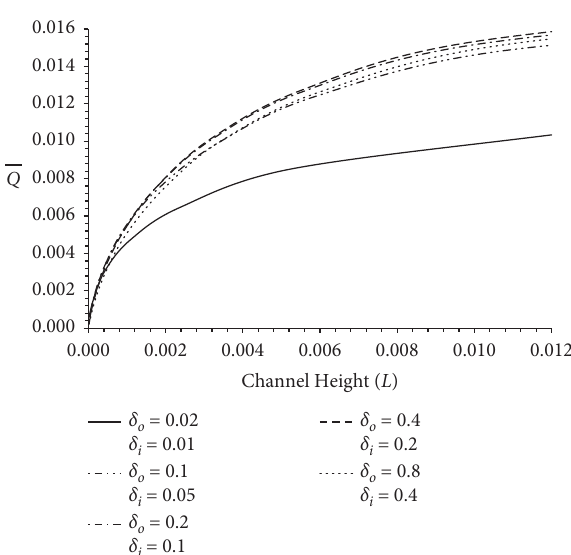
Figure 16: Total heat absorbed versus channel height for different δ